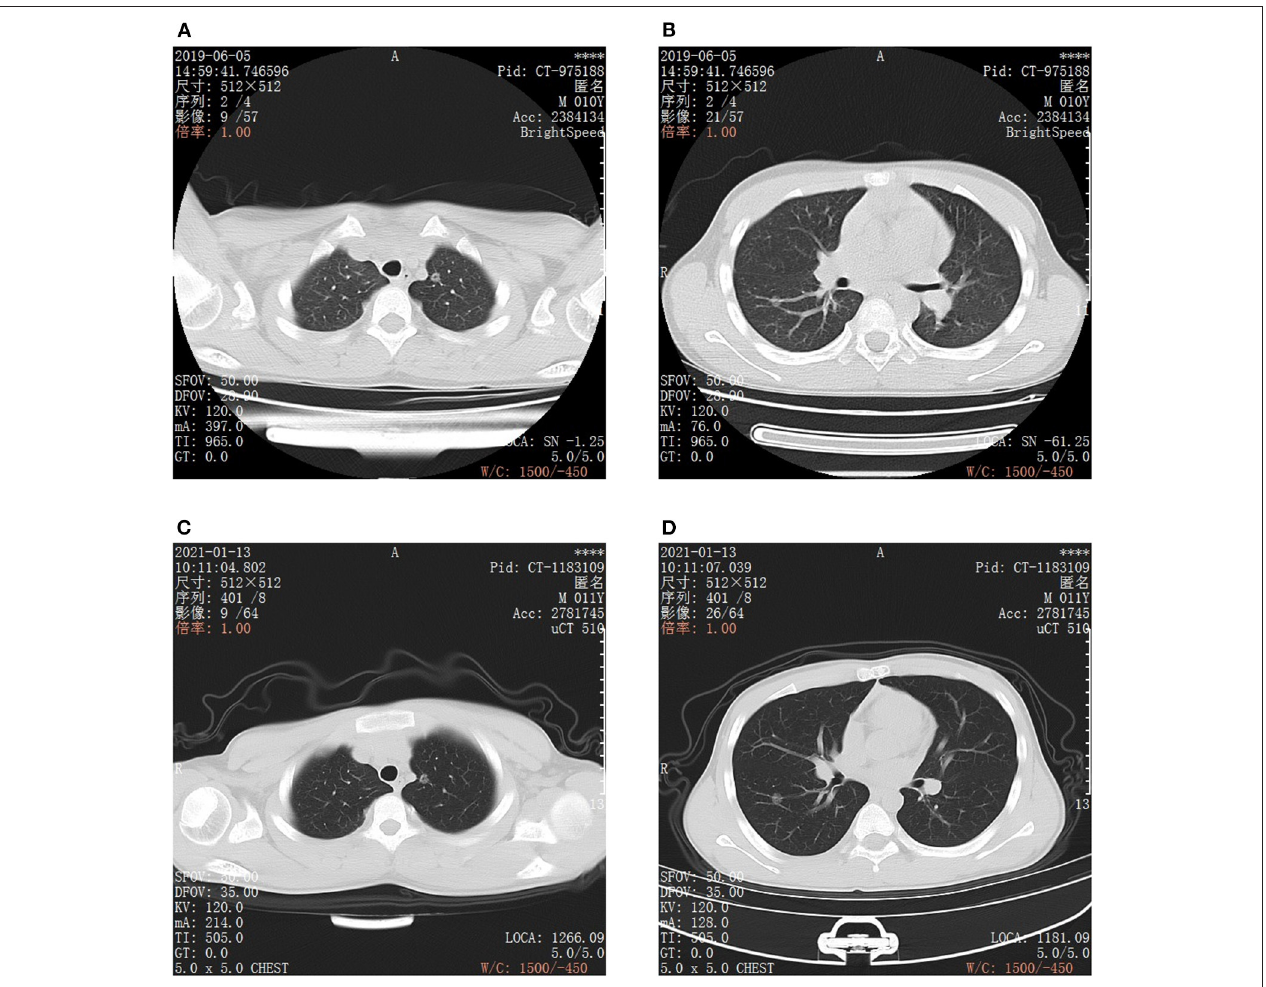
FIGURE 1 | CT images of bilateral chest. (A,B) are CT scan images taken on June 5, 2019, Scanning model: GE BrightSpeed, scanning parameters: slice thickness: 5mm, gap: 5mm. (A) Round ground glass opacity in the posterior segment of the left superior lobe apex, the boundary is clear, in the center, there is a dot-like translucent shadow. (B) Round ground glass opacity in the anterior basal segment of the right lower lobe, the edge is smooth and clear, it can be seen that vascular shadow naturally passes through. (C,D) are CT scan images taken on January 13, 2021, scanning model: United image uCT, scanning parameters: slice thickness: 5mm, gap: 5mm. The 2 ground glass opacities of the posterior segment of the left upper lobe apex (C) and the anterior basal segment of the right lower lobe (D) are roughly similar to that of the film taken on June 05 2019. (C) CT image of ground glass opacity in the posterior segment of the left superior lobe apex. (D) CT image of ground glass opacity in the anterior basal segment of the right lower